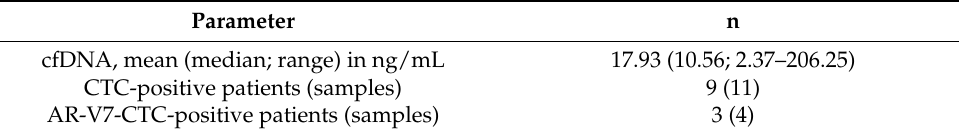
Table 2. Overview of cfDNA concentration and detection of CTCs and AR-V7+